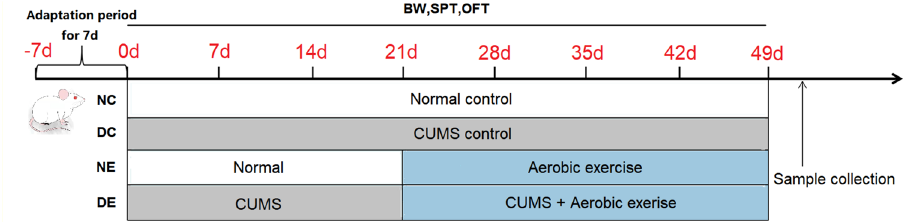
Figure 6. Experimental program and behavior test schedule. BW body weight, SPT sucrose preference test, OFT open field test.